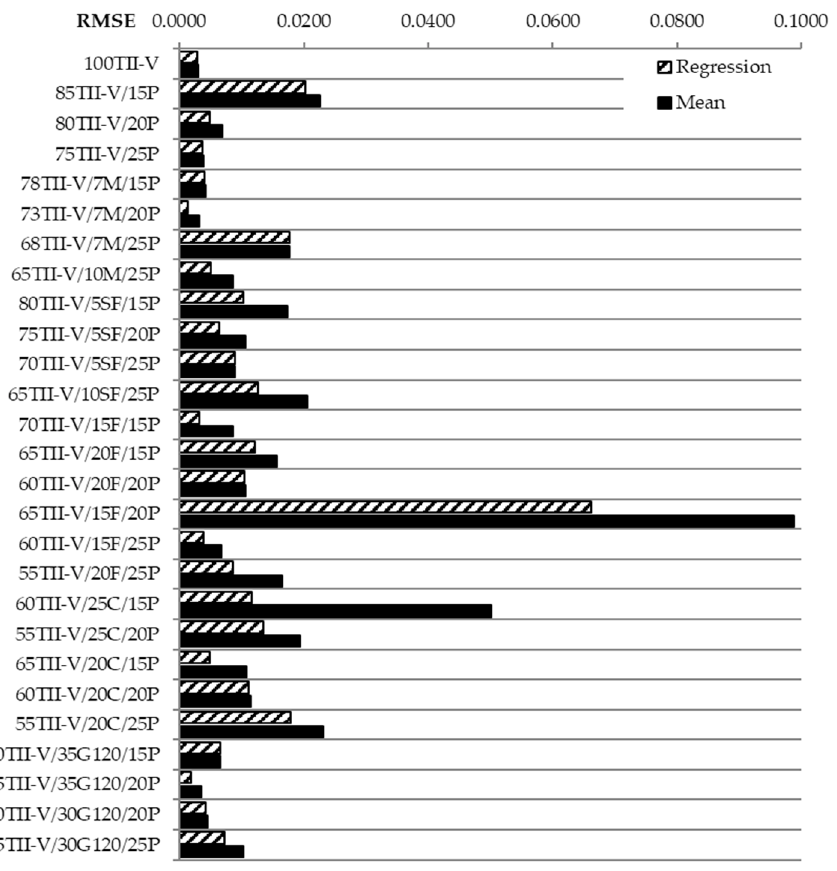
Figure 9. Root mean square error for mean value and trend-line of variation coefficient.